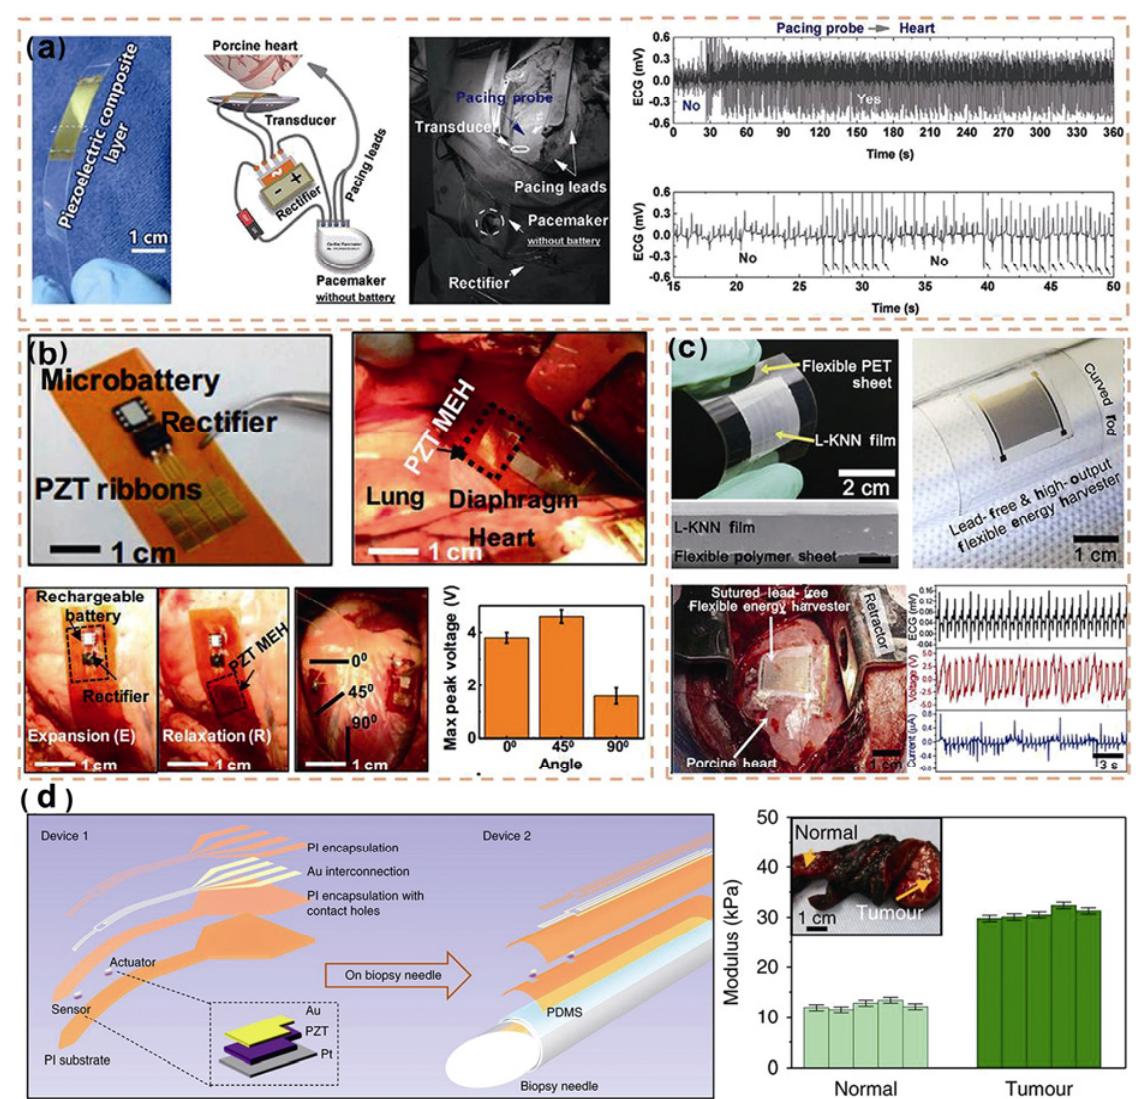
Fig. 10 Implantable application. (a) Photograph of fl exible unfolded piezoelectric component and feasibility evaluation of exocardial pacing relied on the batteryless cardiac pacemaker. (b) Photograph of PZT mechanical energy harvester (MEH) connected to and cointegrated with a rectifier and rechargeable microbattery and its in vivo evaluation on lung and heart. (c) Photograph of lead-free LiNbO 3 -doped KNN (L-KNN) film FPEH and its in vivo evaluation on porcine heart. (d) Structure of tissue modulus probes based on ultrathin PZT actuators and sensors and measurement of tissue modulus performed using a sensor system laminated onto a conventional biopsy needle. Reproduced with permission from Ref. [16] for (a), © WILEY-VCH Verlag GmbH & Co. KGaA, Weinheim 2020; Ref. [156] for (b), © National Academy of Sciences 2014; Ref. [159] for (c), © Author(s) 2017; Ref. [167] for (d), © Macmillan Publishers Limited, part of Springer Nature